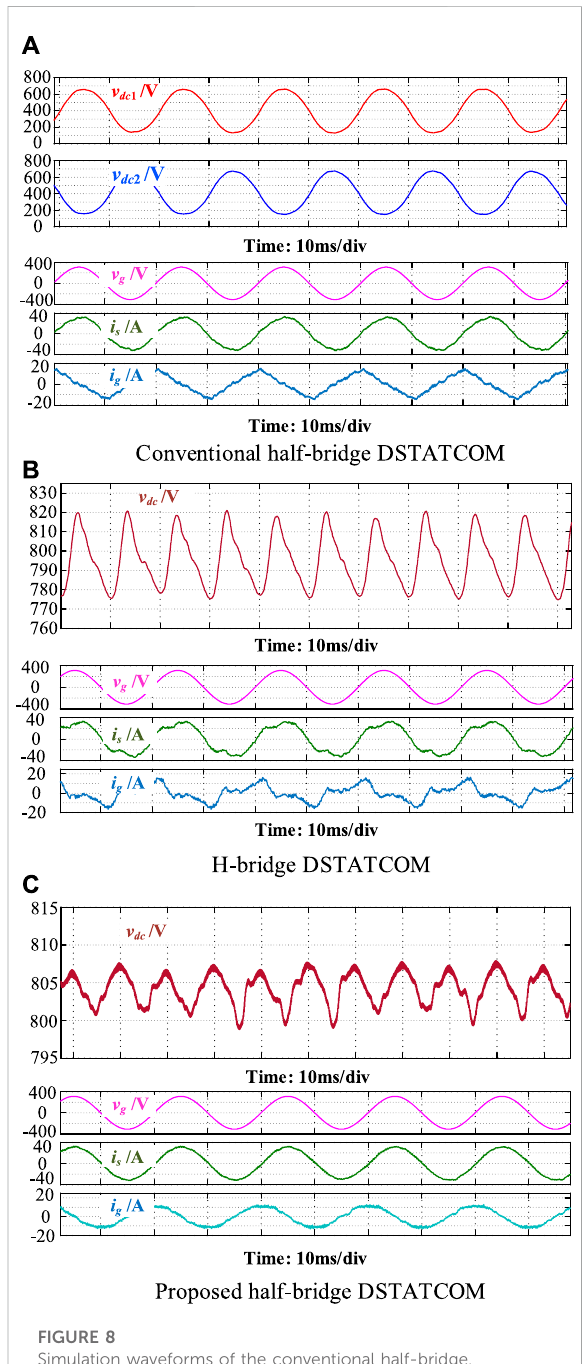
FIGURE 8 Simulation waveforms of the conventional half-bridge, H-bridge, and proposed half-bridge DSTATCOMs. (A) Conventional half-bridge DSTATCOM. (B) H-bridge DSTATCOM. (C) Proposed half-bridge DSTATCOM.